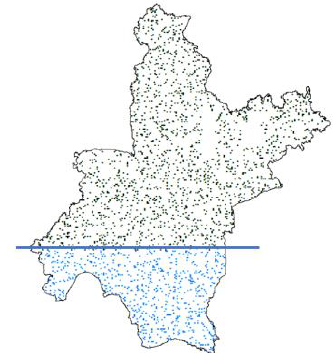
Figure 5. In the first classification stage, 4200 512 × 512 patch samples retrieved from the 2017 image are used for evaluating different algorithms’ performance, where the 3500 black rectangles above the line are training and validation data and the 700 blue ones below the line are test data. In the second stage, all the image pixels above the line are used for training and the rest for testing.